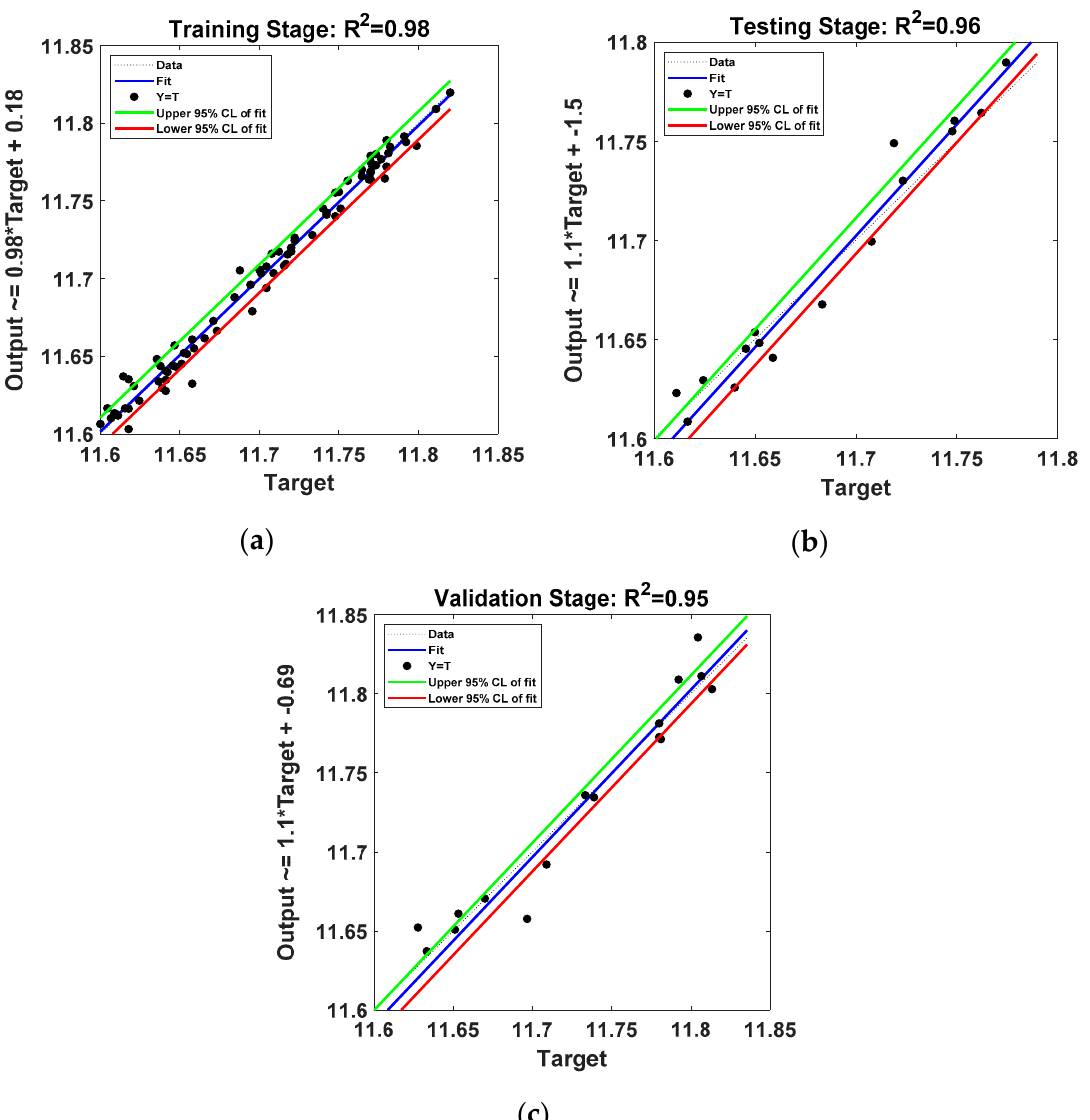
Figure 7. Performance of ANN (stand-alone) model in the ( a ) training stage, ( b ) testing stage and ( c ) validation stage.